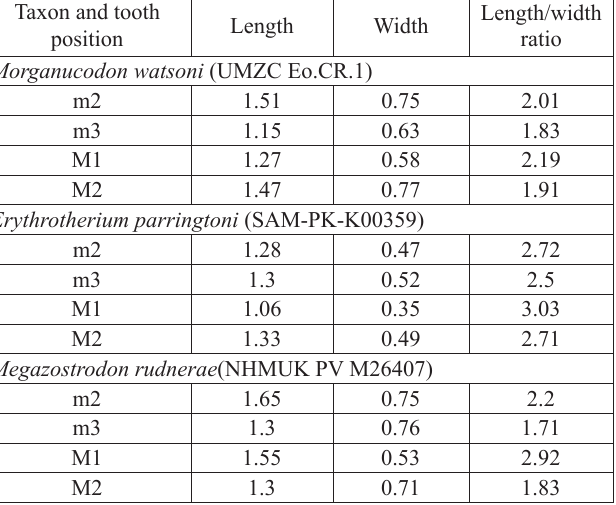
Table 1. Length and width measurements (in mm) of the molars of the morganucodontids Morganucodon watsoni (UMZC Eo.CR.1), Erythrotherium parringtoni (SAM-PK-K00359, holotype), and the holotype) examined in this